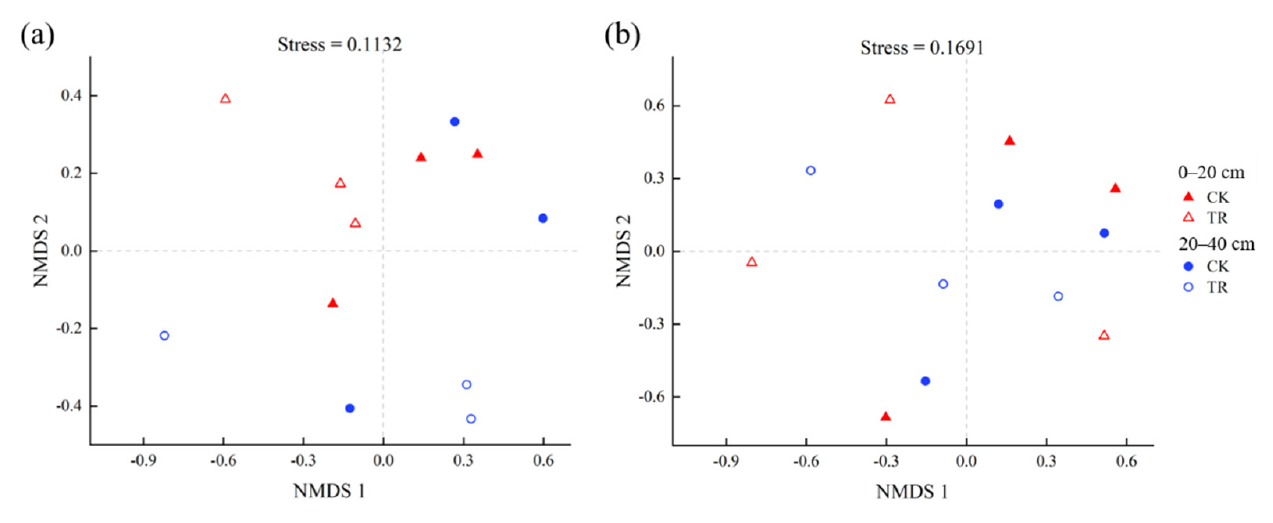
Figure 4. Non-metric multidimensional scaling (NMDS) analysis based on the Bray–Curtis distance for the bacterial ( a ) and fungal ( b ) community. The result of ANOSIM were listed. Triangle stand for 0–20 cm soil depth, circles stand for 20–40 cm soil depth. Open symbols stand for TR treatment, solid symbols stand for CK treatment.